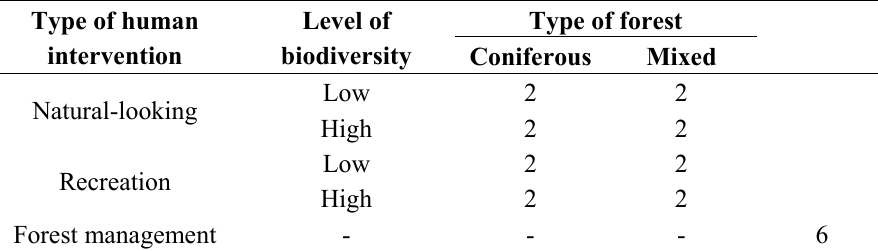
Table 2. Overview of the forest scenes analyzed in this